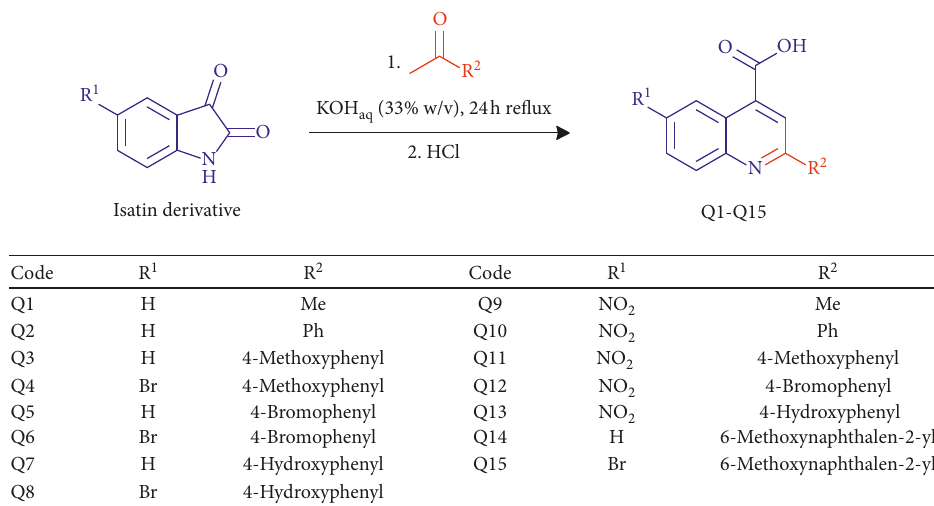
Scheme 1: Synthetic pathway of quinoline-4-carboxylic Table 1: IC 50 of the synthesized quinolines and positive controls.